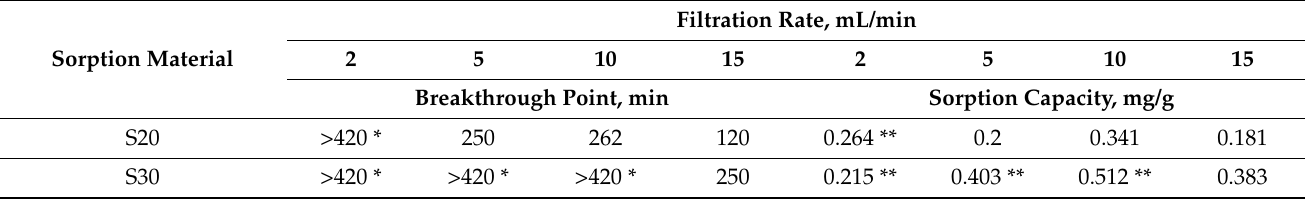
Table 3. The influence of filtration rates on breakthrough point times (min) and P sorption capacities (mg/g).